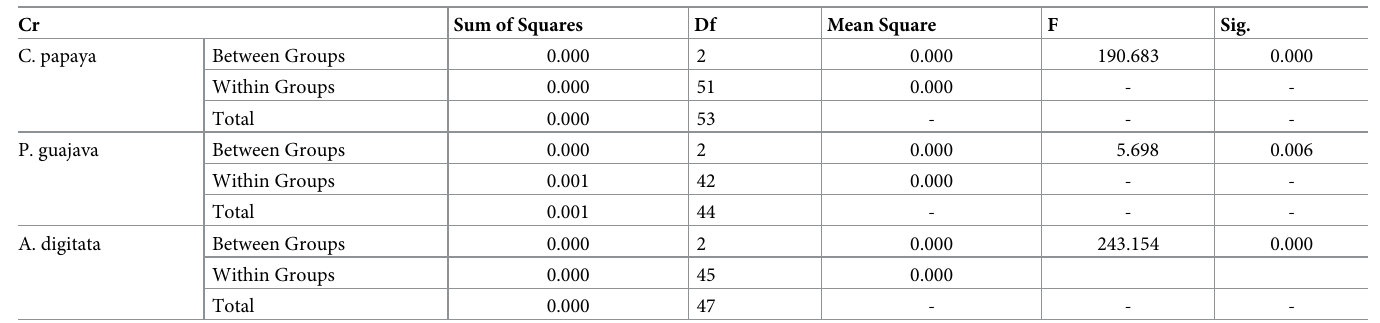
Table 5. ANOVA analysis table for Cr.